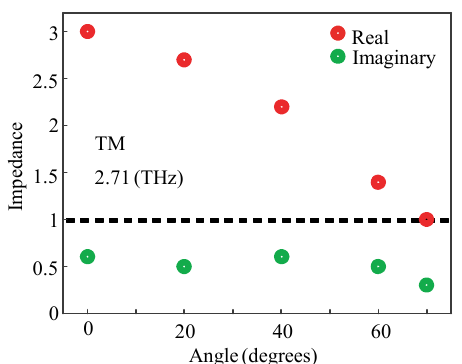
Fig. 6 Real and imaginary parts of relative impedance as a function of an angle of incidence for a TM mode at 2.71 THz.